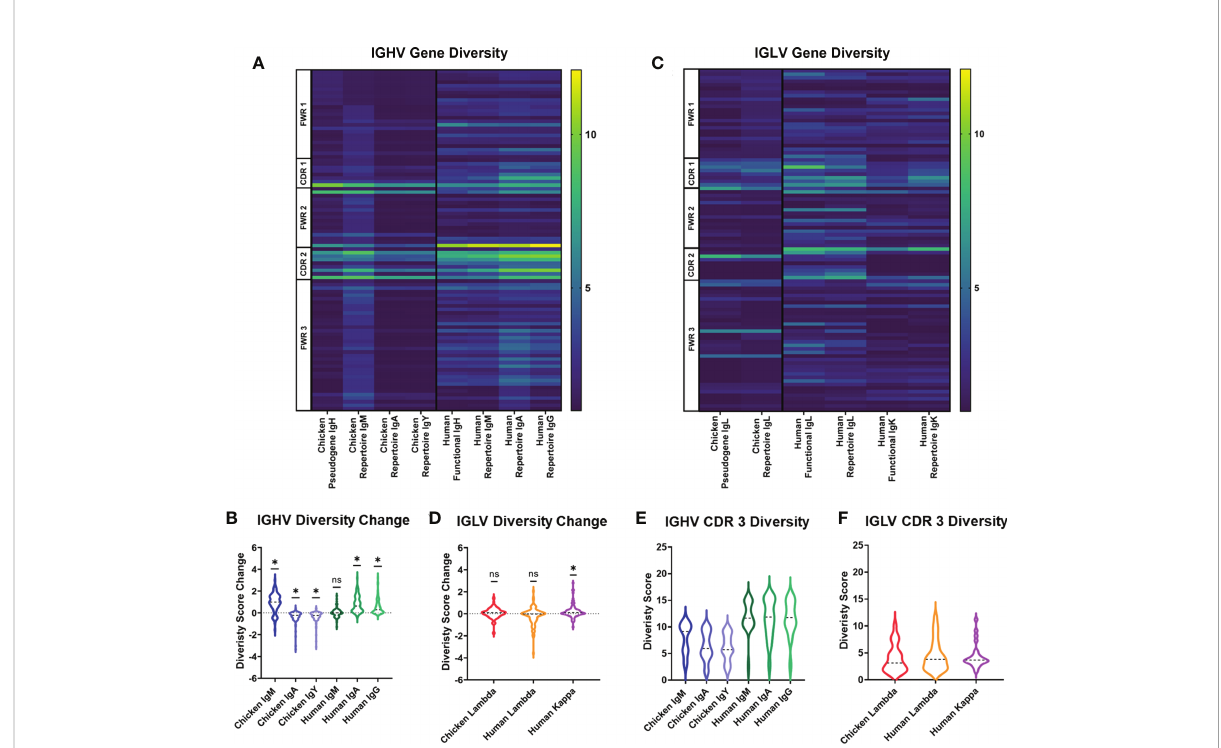
FIGURE 1 Diversity score analysis of each amino acid position in the germline immunoglobulin variable genes and repertoire sequences for each antibody class in both species. (A) Diversity score for each amino acid position of heavy chain germline and repertoire sequences. N: chicken heavy chain pseudogenes = 120, human heavy chain functional genes = 351, chicken IgA repertoire sequences = 7,273, chicken IgM repertoire sequences = 43,243, chicken IgY repertoire sequence = 47,871, human IgM repertoire sequences = 133,521, human IgA repertoire sequences = 166,524, and human IgG repertoire sequences = 96,113. (B) Analysis of diversity score change between germline and repertoire in heavy chain sequences of both chickens and humans. Negative diversity score change indicates a decrease in diversity, and positive diversity score change indicates increase in diversity. Statistical signi fi cance calculated using Wilcoxon rank sum test (WRST), analysing the difference between a theoretical mean of 0 and the actual median. p-Values: ns = p > 0.05, *p ≤ 0.05. (C) Diversity score for each amino acid position of light chain germline and repertoire sequences. N: chicken lambda light chain pseudogenes = 49, chicken lambda repertoire sequences = 38,244, human lambda light chain functional genes = 85, human kappa light chain functional genes = 99, human lambda repertoire sequences = 38,244, and human kappa repertoire sequences = 158,668. (D) Analysis of diversity score change between germline and repertoire in light chain sequences of both chickens and humans. Statistical signi fi cance calculated using WRST. p-Values: ns = p > 0.05, *p ≤ 0.05. (E) Analysis of diversity scores for amino acid positions in the CDR3 region of heavy chain antibody repertoires in both chickens (IgM, IgA, and IgY) and humans (IgM, IgA, and IgG). Statistical analysis was performed using a one-way ANOVA to compare the means using Bonferroni ’ s corrections to mitigate multiple comparisons. p-Values: ns = p > 0.05, *p ≤ 0.05. (F) Analysis of diversity scores for amino acid positions in the CDR3 region of light chain antibody repertoires in both chicken lambda and human lambda and kappa. Statistical analysis was performed using a one-way ANOVA to compare the